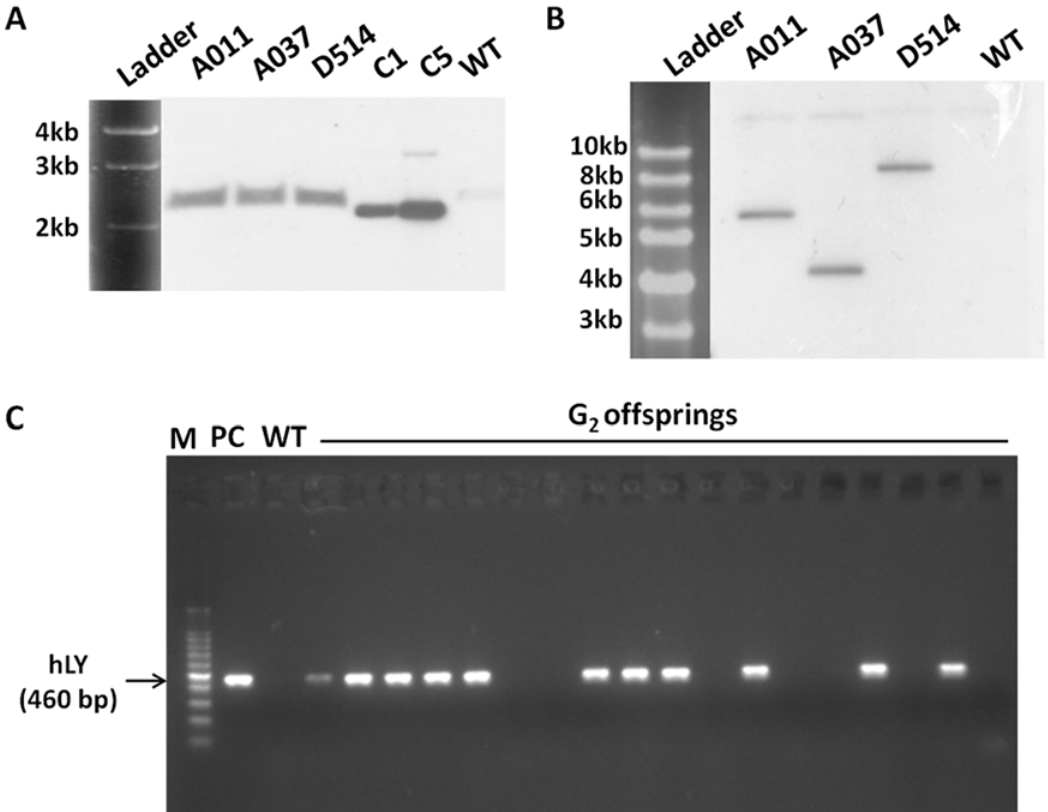
Fig 4. The identification of transgenic chicken. (A, B) Southern blot analyses of genomic DNA from individual G1 birds. Genomic DNA samples (10 μ g) were digested with Pvu II(A) or Nde I (B) to generate either a fragment (2.3 kb) spanning the vector or a junction fragment between viral and chicken genomic sequences respectively, then hybridised with a probe for hLY. (C) PCR analysis of genomic DNA from blood of G 2 offspring sired by A011. A011, A037 and D514, G 1 offspring of G 0 birds injected with pWPXL-EREOV-hLY. WT, wild-type White Leghorns. C1, plasmid control with a copy number of 1. C5, plasmid control with a copy number of 5. PC, positive control.